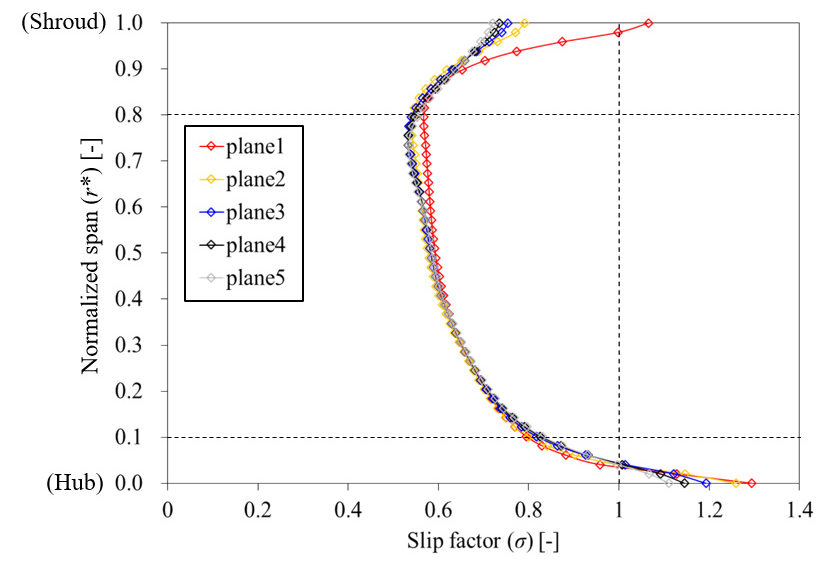
Figure 5. Slip factor distribution over the entire span for the wall-mounted axial fan (1.0 Φ d ).